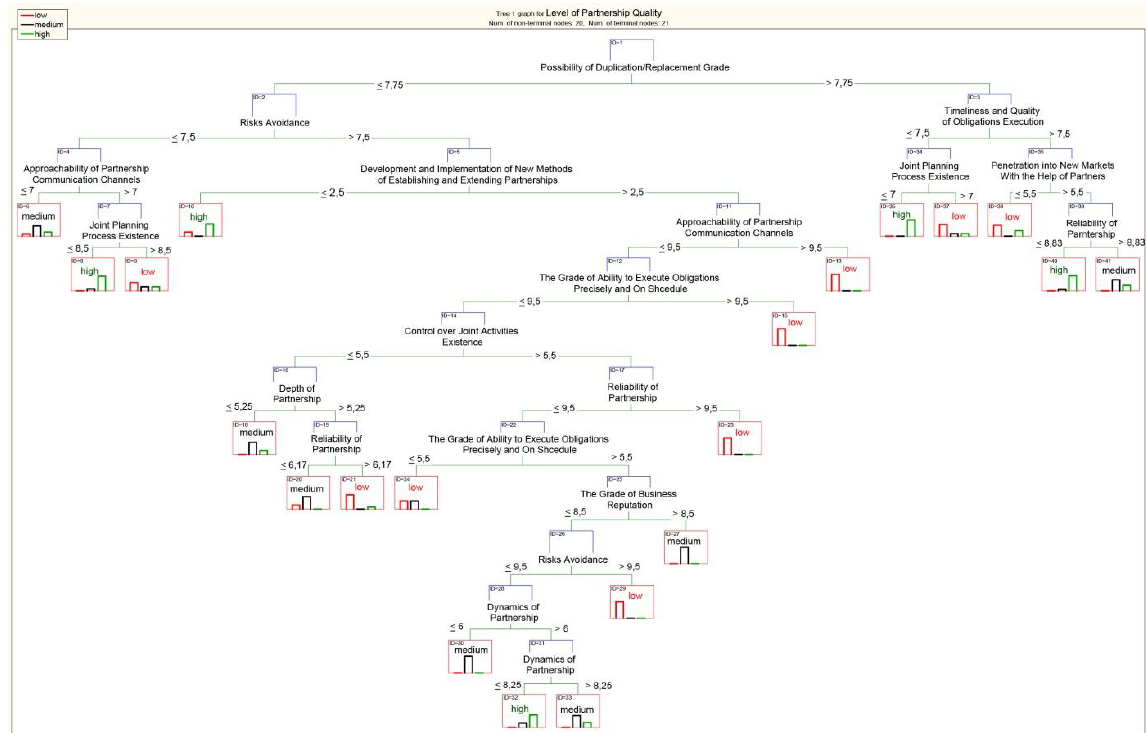
Fig. 3. Algorithm for building a ―decision tree‖ for the selection of optimal partners in the system of promotion of pharmaceutical products based on multicriteria